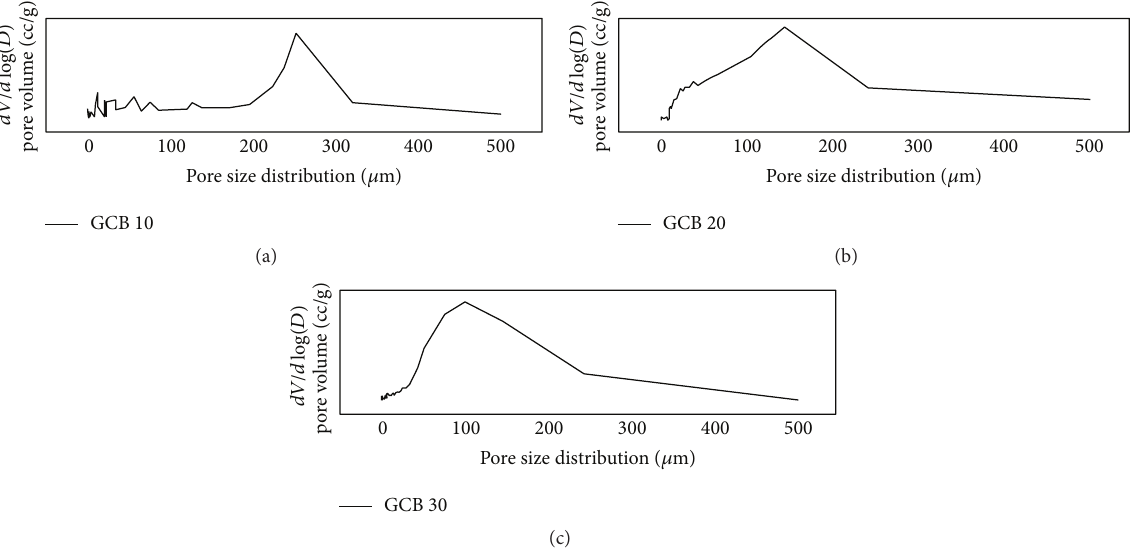
Figure 8: Pore size distribution data of gelatin-chitosan-bioglass scaffold: (a) GCB 10, (b) GCB 20, and (c) GCB 30.